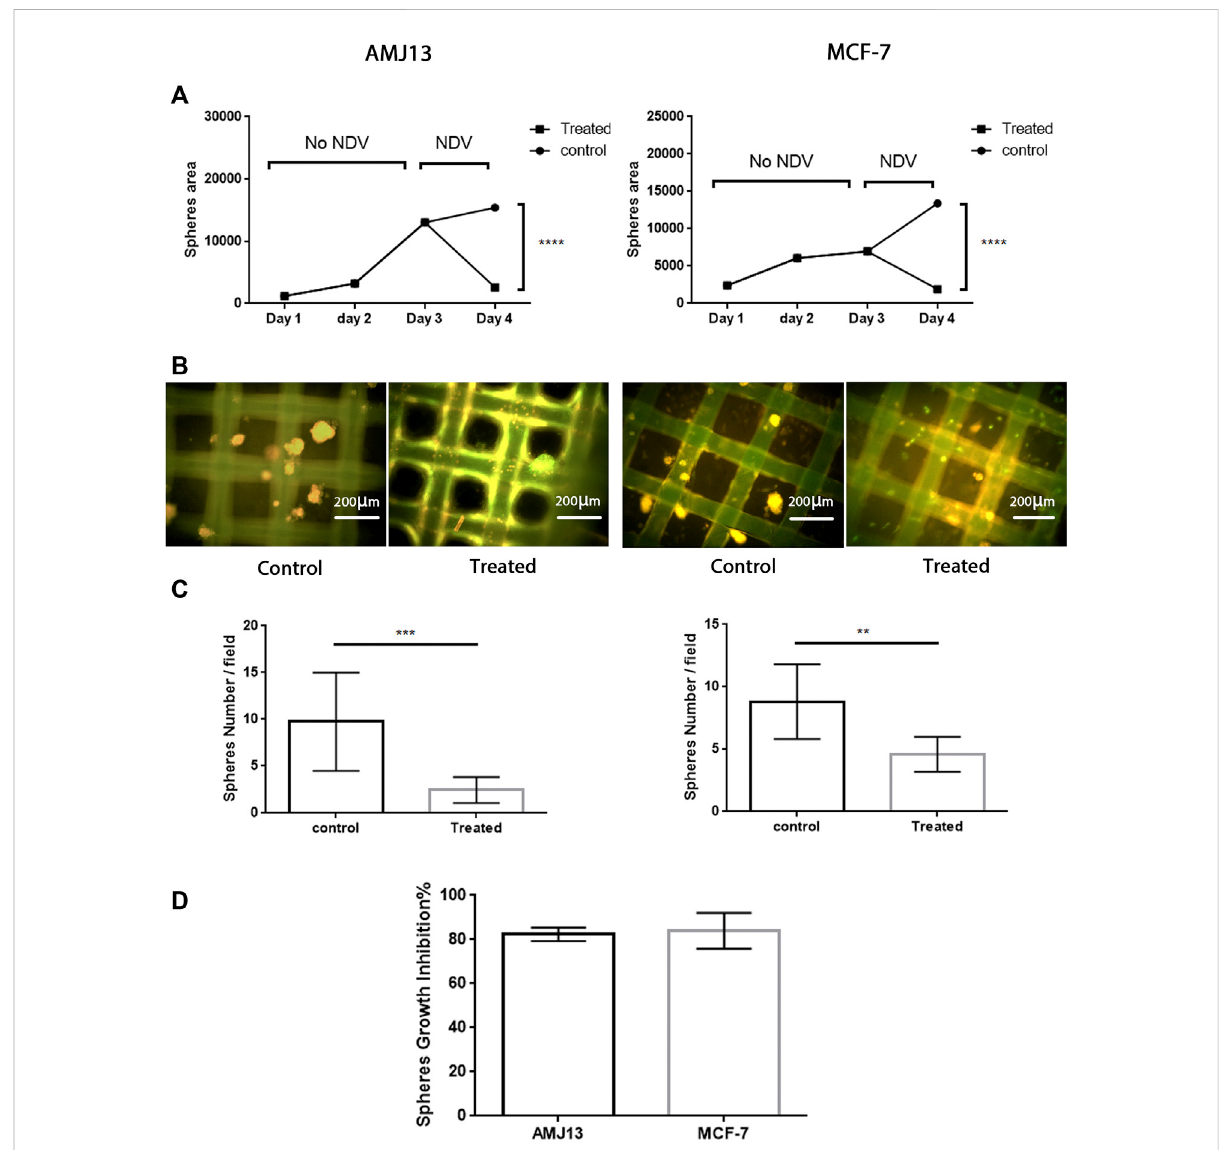
Antitumor assessment of the PKH67-NDV AMHA1 against the 3D breast cancer – hATMSCs spheres. Three-dimensional cocultures of AMJ13 and MCF7 cell lines and normal stem cells were exposed to labeled NDV AMHA1 at an MOI of 10 for 24 h post-infection. (A) Growth curve showing the steady growth of the spheres in size as measured by area, through 3 days until exposed to PKH67-NDV, where the spheres size drops due to oncolysis effect when compared to that of mock-infected cells. (B) Immuno fl uorescence image showing mostly green fl uorescent PKH67-NDV infection decreased the number of spheres when compared to the control noninfected spheres. The control spheres show orange propidium iodide that stains the cell nuclei red. (C) Signi fi cant decreases seen in spheres number. (D) Sphere ’ s growth inhibition showed more than 80% for each cell line tested, indicating that PKH67-NDV can ef fi ciently prevent breast cancer spheroids ’